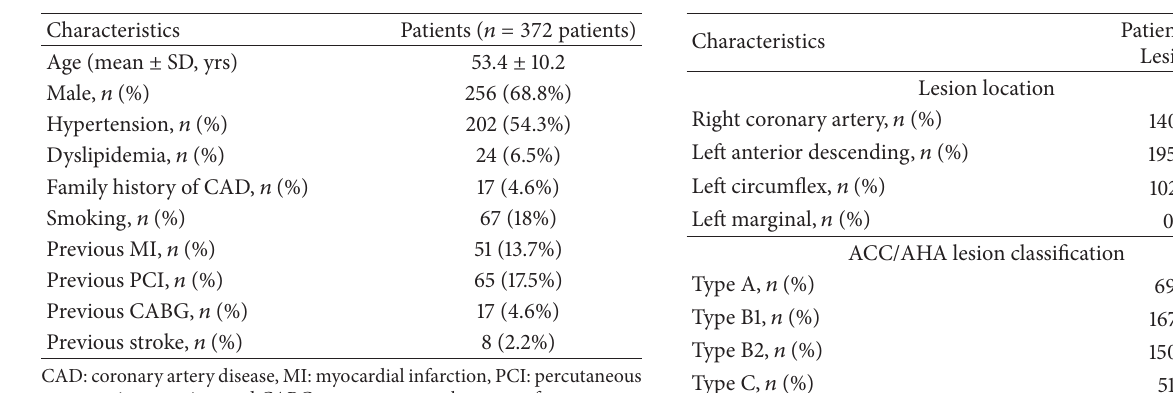
Table 1: Baseline demographic characteristics. Table 2: Angiographic and procedural characteristics.